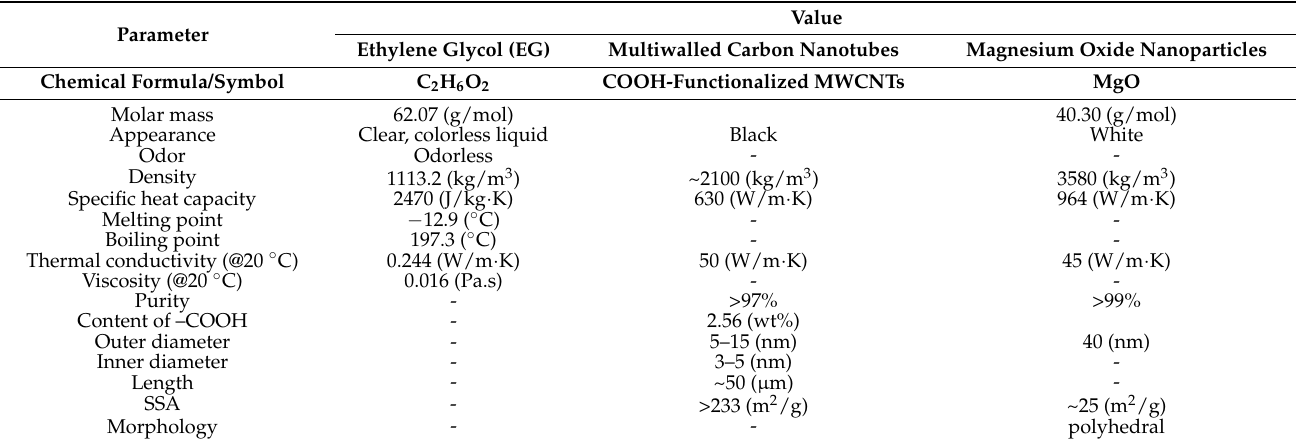
Table 7. Material properties [56].